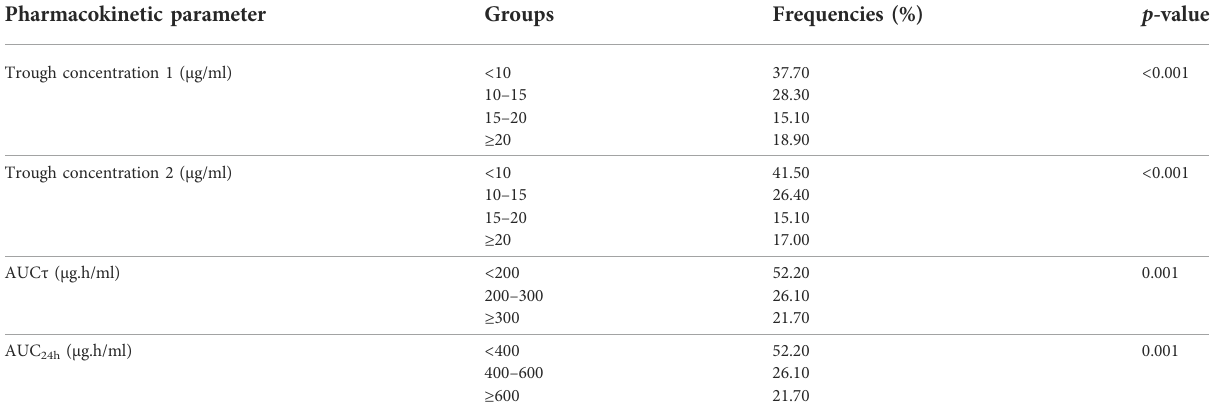
TABLE 5 Comparison of occurrence of vancomycin-induced AKI in different groups of patients based on trough concentration andAUCvaluesusing Chi-square test ( N = 53). Pharmacokinetic